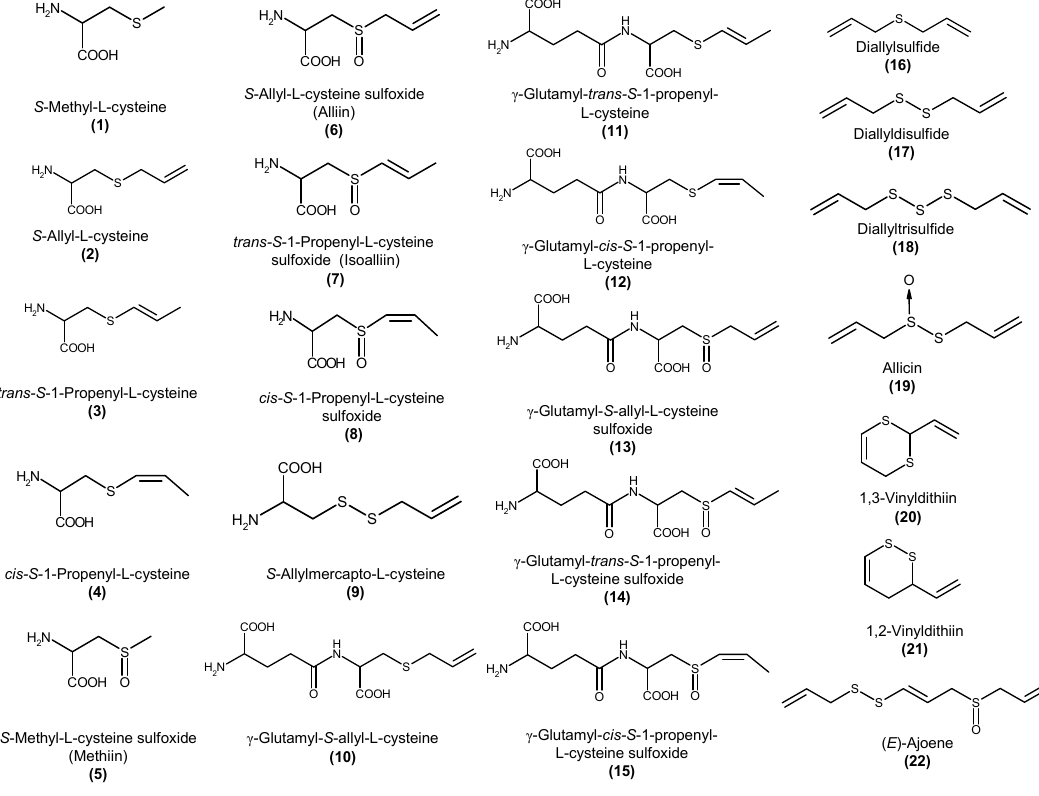
Figure 1. Chemical structures of sulfur-containing compounds derived from garlic.